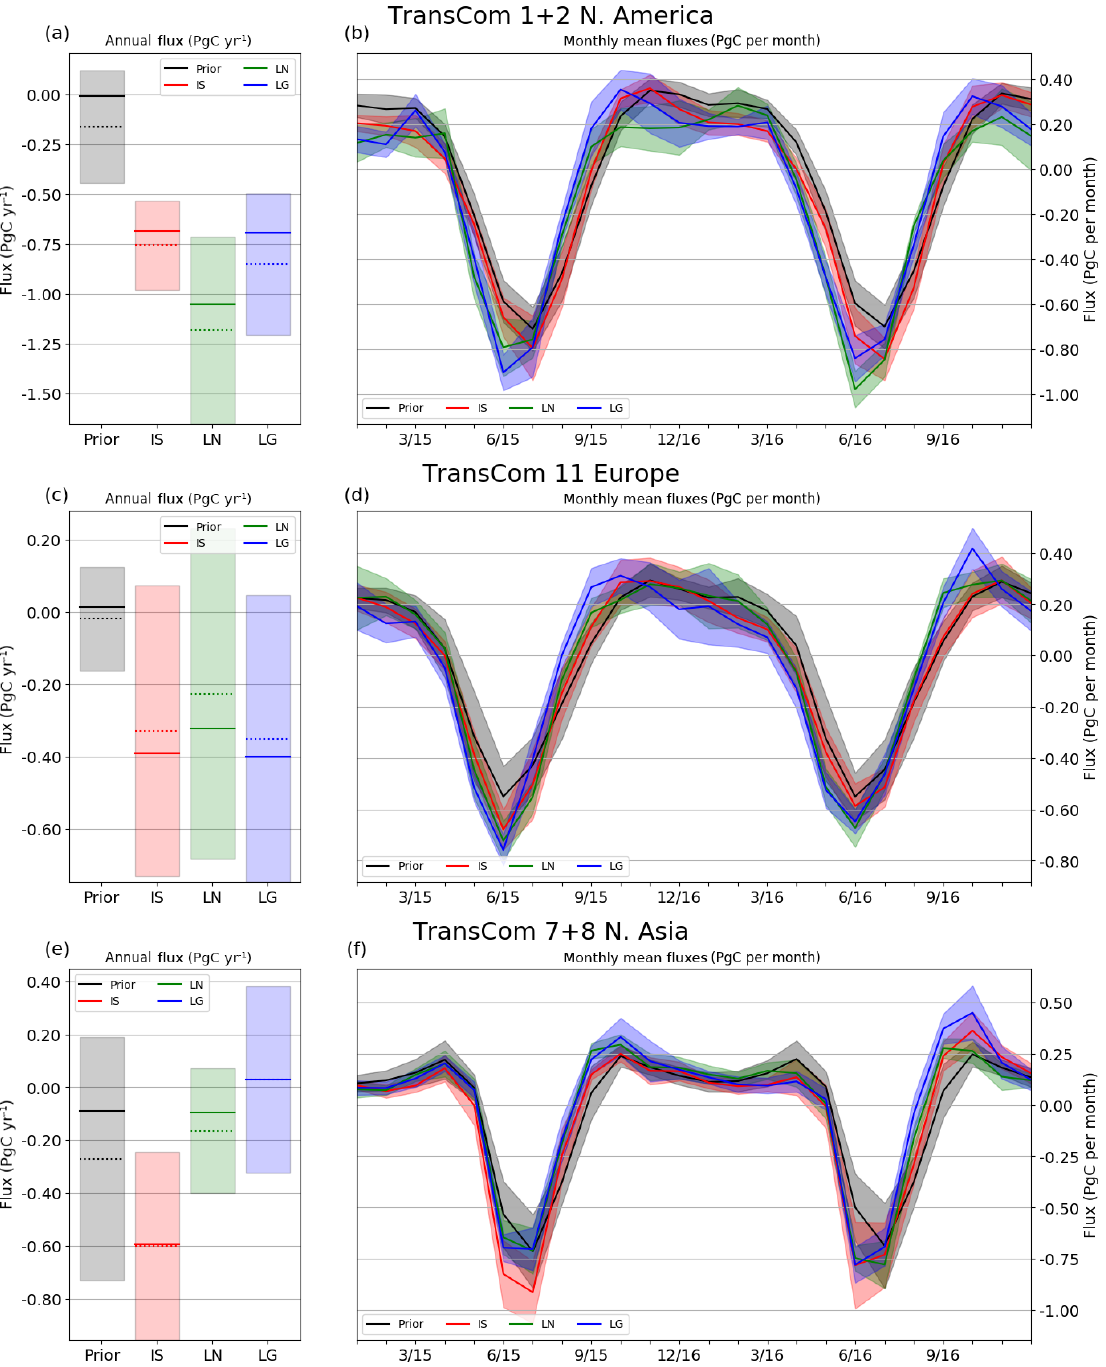
Figure 5. As in Fig. 3, but for three continental-scale land regions in the northern extratropics. The monthly fluxes show broad agreement between the in situ and OCO-2 experiments in terms of seasonality and peak drawdown. The fluxes show differences in North America, where the summertime peak sink is larger and wintertime respiration is smaller in the LN experiment results than the other two. The three experiments agree for Europe, which diverges from results in Houweling et al. (2015) in which GOSAT retrievals lead to a much stronger sink in Europe than the in situ measurements. In both Europe and Asia, LG experiment results display the enhanced outgassing in the autumn in 2016 present in the northern extratropics seen in Fig.